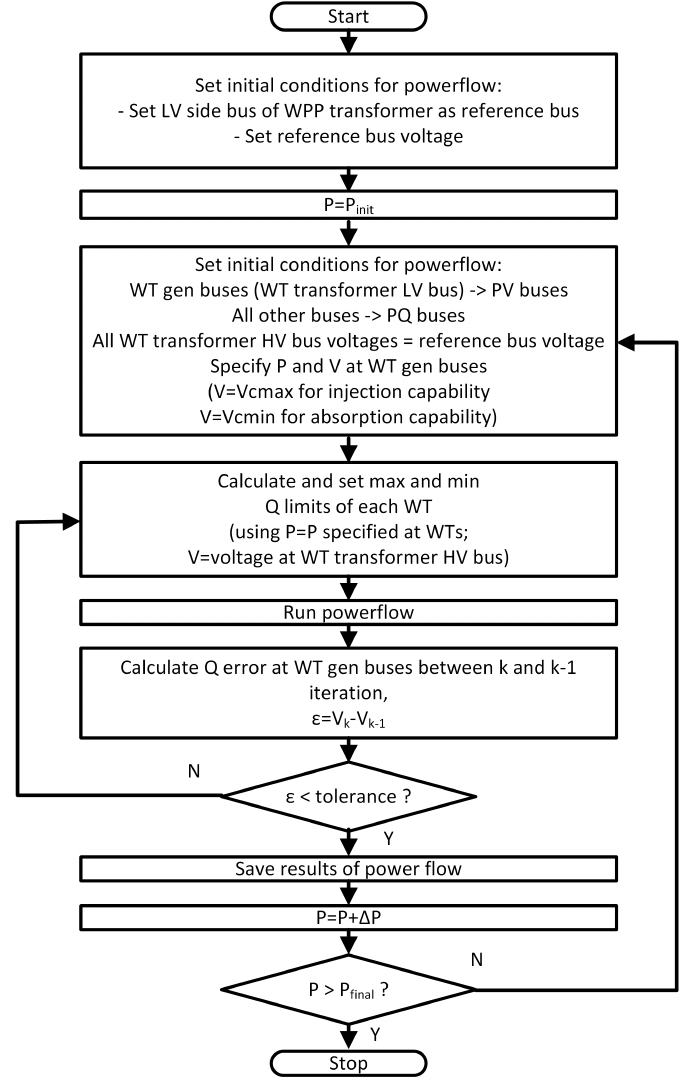
Figure 7. Flowchart to determine WPP reactive power capability using detailed